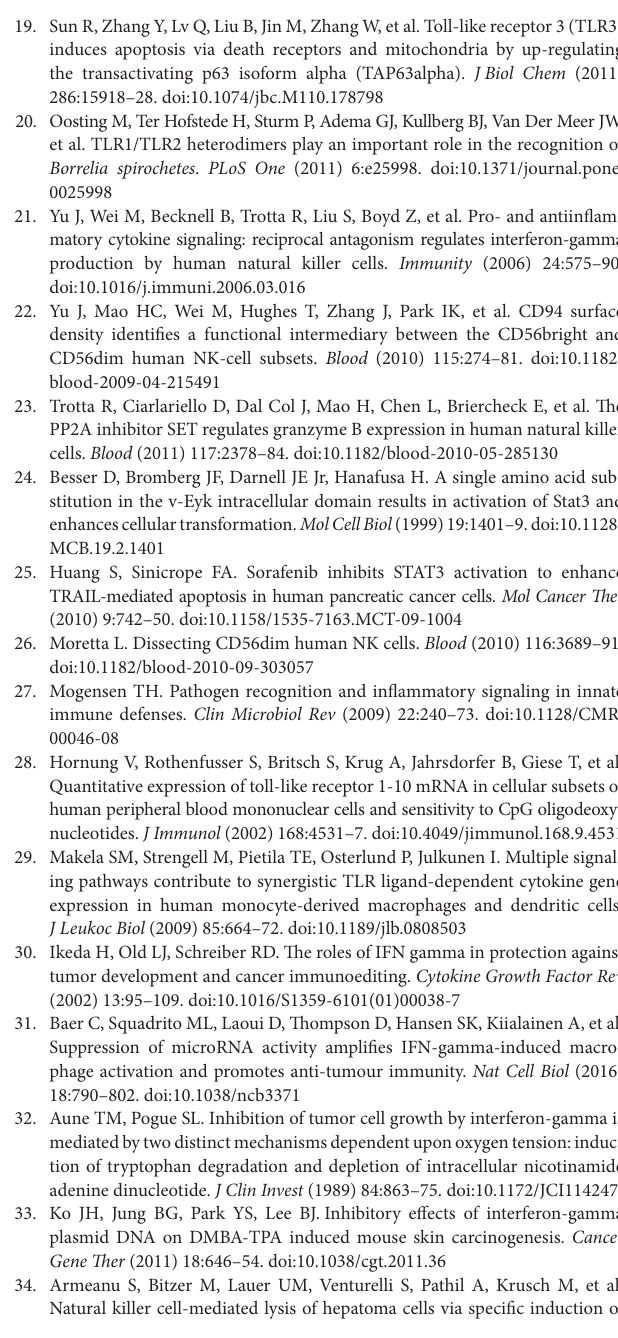
FigUre s5 | TAARD does not affect phosphorylation of STAT4 and STAT5 in NK cells. (a,B) Purified primary human NK cells and NKL cells were treated with 0.1 µM of either TAARD alone or in combination with 100 ng/mL of IL-12 (a) or 100 ng/mL of IL-15 (B) for 6 h. Cells were harvested and lysed for immunoblotting using antibodies against STAT4 or STAT5. β -actin was included as the internal control. FigUre s6 | Effects of TAARD on the mRNA expression levels of potential target genes. Purified human NK and NKL cells were treated with 0.1 µM of TAARD for 18 h and then cell pellets were harvested to detect mRNA expression levels by real-time RT-PCR. Data shown are the means of three donors.